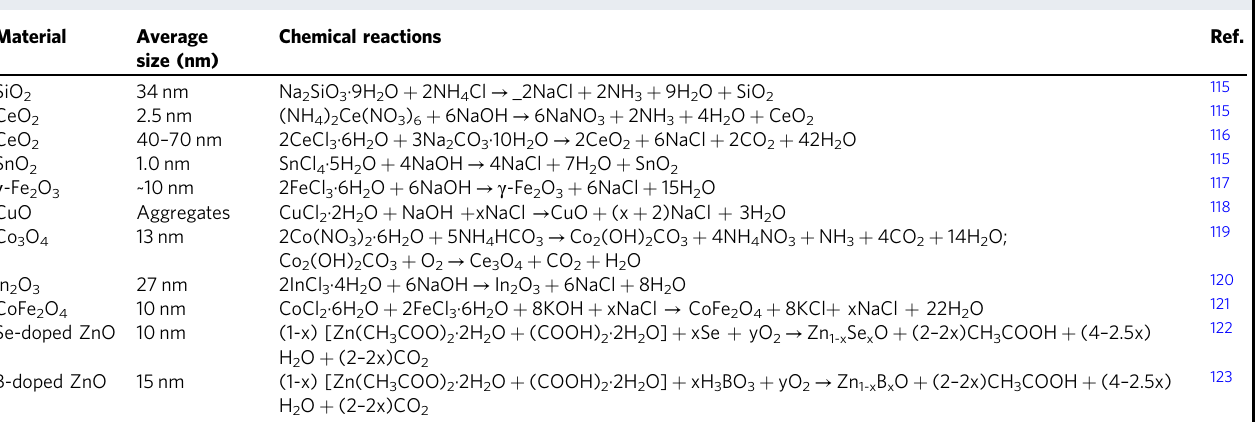
Table 4 Examples of metal-oxide nanoparticles produced by soft-mechanochemical processing (not a comprehensive list). Material Average size